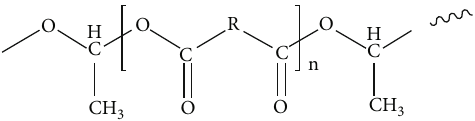
Figure 59: Chemical structure of